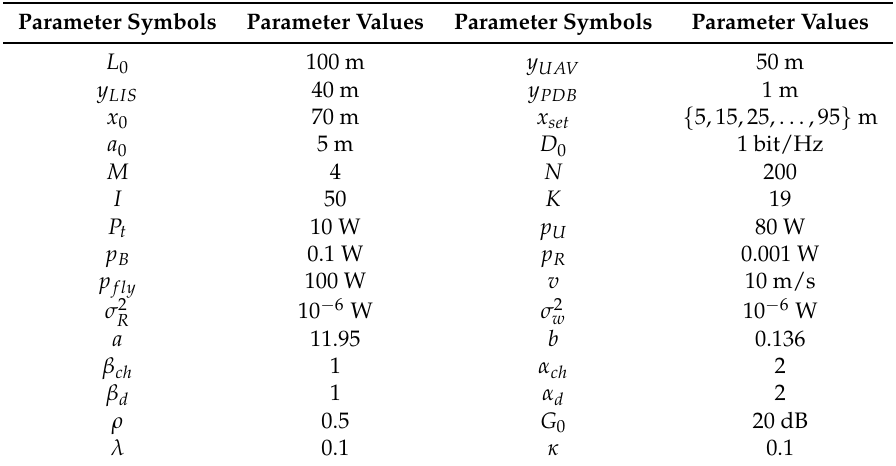
Table 2. Reasonable parameters used in the